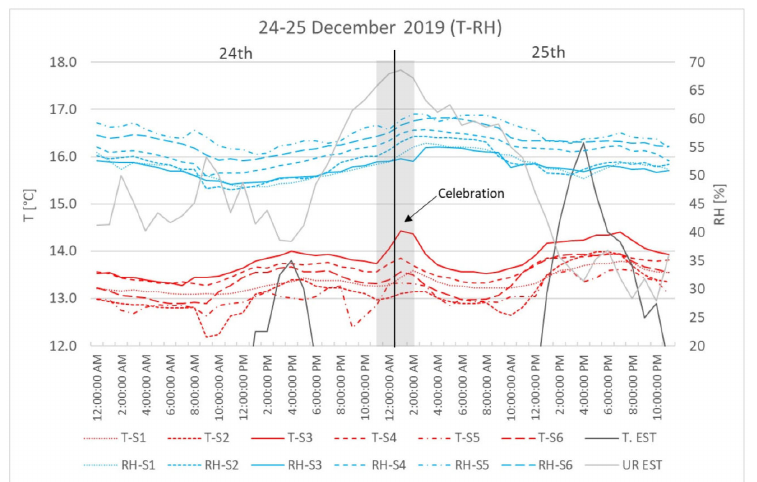
Figure 8. Internal and external temperature and relative humidity values during 24–25 Decem- ber 2019; the grey area indicates the celebration